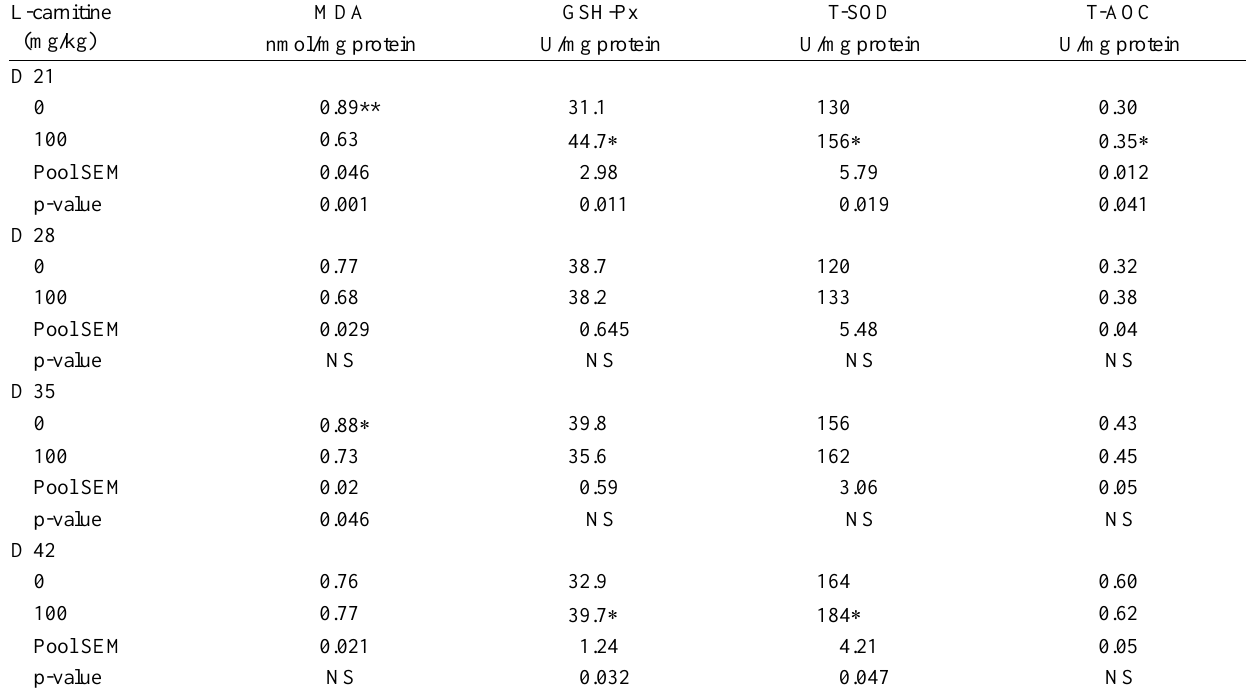
Table 4. Effects of dietary L-carnitine supplementation on heart antioxidative